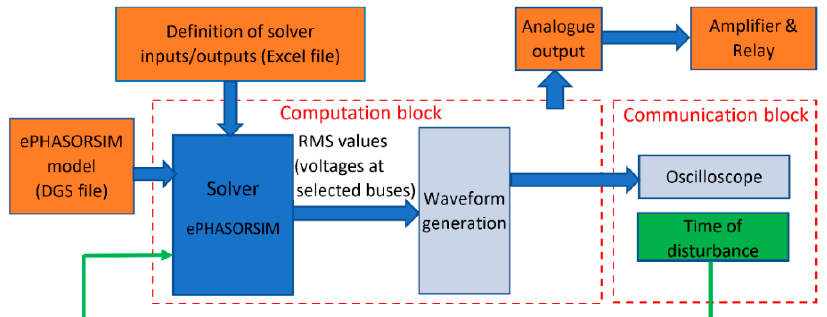
Figure 9. Simplified block diagram of the Simulink model including basic inputs/outputs.